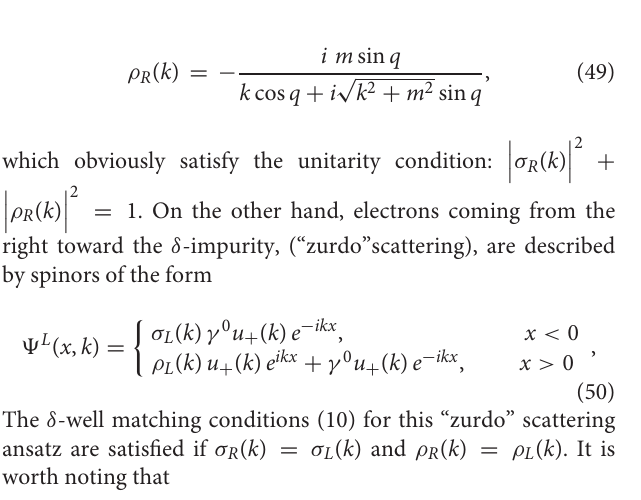
FIGURE 2 | Charge density as a function of x when Q (electrostatic δ -potential). For 0 < q < π/ 2 and π < q < 3 π/ 2 the charge densities of a positron bound state are plotted [(44), (45), respectively]. For π/ 2 < q < π and 3 π/ 2 < q < 2 π the charge densities of a electron bound state are plotted [(46), (47),